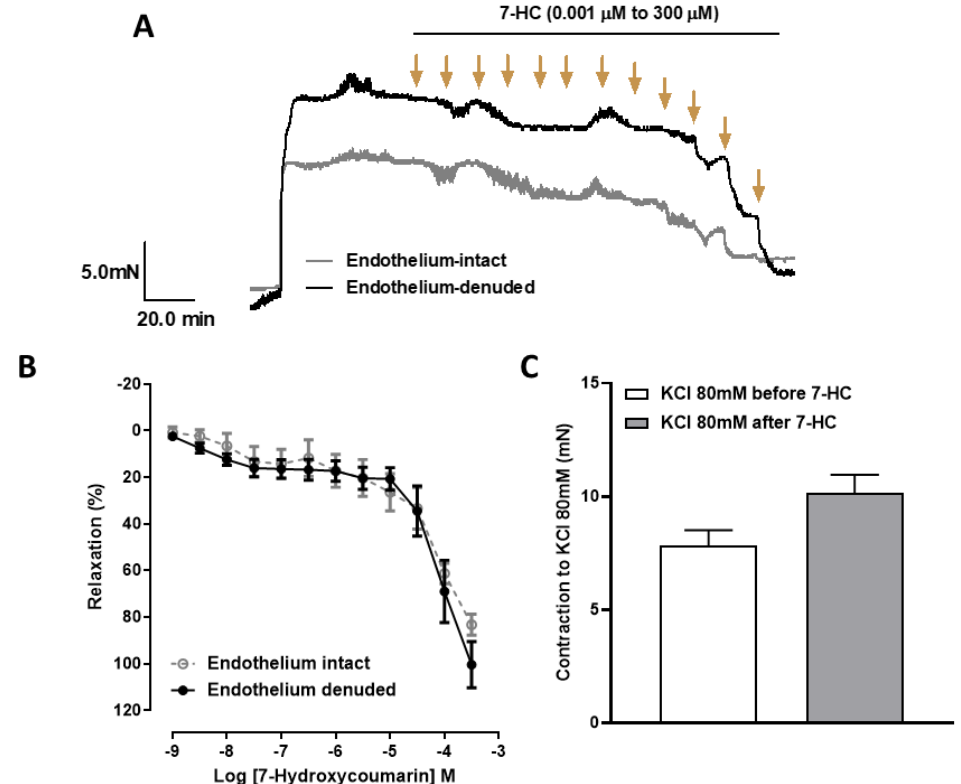
Figure 1. Vasorelaxation effects of 7-HC in the superior mesenteric artery from SHR. ( A ) Representative original recordings of the effects of 7-HC in endothelium-intact and endothelium-denuded mesenteric arteries of rats. ( B ) Relaxation responses induced by 7-HC (0.001–300 µ M) in endothelium-intact ( ○ , n = 6) and endothelium-denuded ( ● , n = 6) rat mesenteric arterial rings, pre-contracted with Phe (1 μ M). ( C ) Bar graphs showing the contraction induced by Tyrode ’ s solution containing